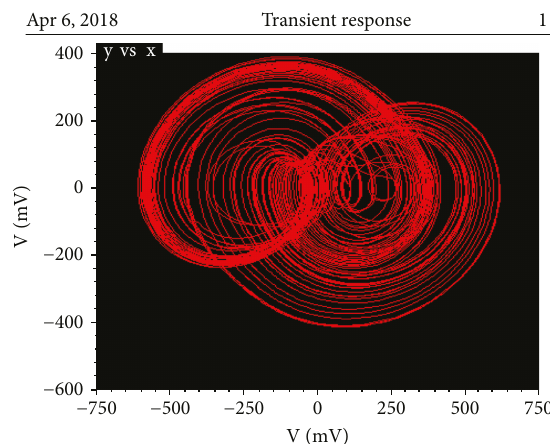
Figure 14: The phase portrait in the x - y plane (S and S are turned o ff ). 3